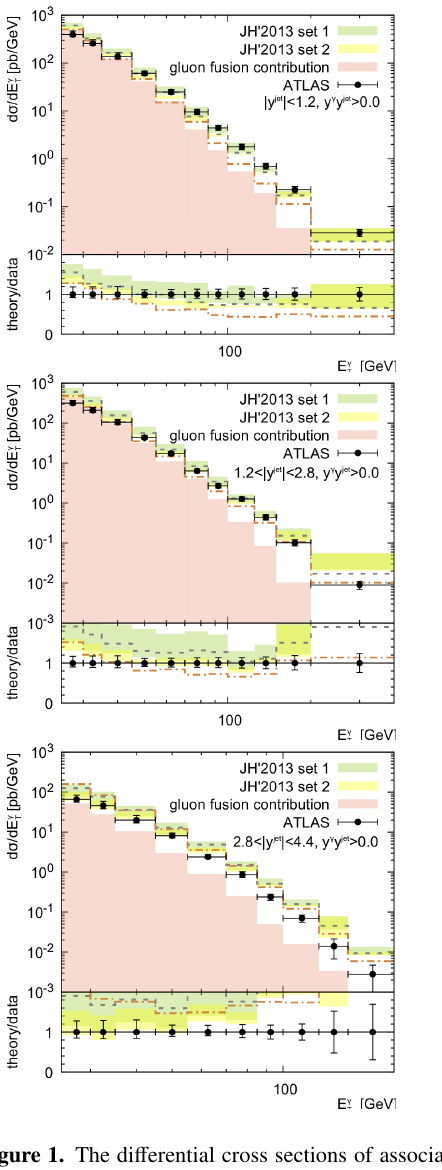
Figure 1. The di ff erential cross sections of associated γ + jet production at √ s = 7 TeV as function of the prompt photon transverse energy E γ in di ff erent regions of rapidities. The green and yellow T shaded band represent the results obtained with JH’2013 set 1 and set 2 gluon densities (with scale uncertainties). Dashed histograms corresponds to the predictions without final-state parton showers, dash-dotted histograms correspond to the results, obtained with simple approach[16]. Separately shown contribution from the o ff -shell gluon-gluon fusion subprocess (1). Everywhere the JH’2013 set 1 gluon density was used. The experimental data are from ATLAS[21].